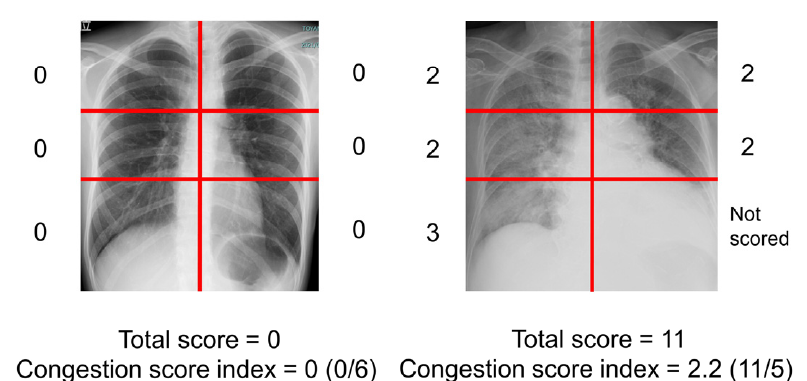
Figure 2. How to measure congestion score index of chest X-ray (examples are displayed). The scoring of congestion was performed on each 6-segment of lung fields and the grades of congestion were defined as follows; 0 = normal, 1 = cephalization, perihilar haze, peribronchial cuffing, or Kerley lines; 2 = interstitial pulmonary edema and localized or confluent mild edema; 3 = confluent intense edema. The total score was obtained. If a segment covered with pleural effusion, the segment was not scored. The congestion score index was calculated as the total score divided by number of available lung segments.